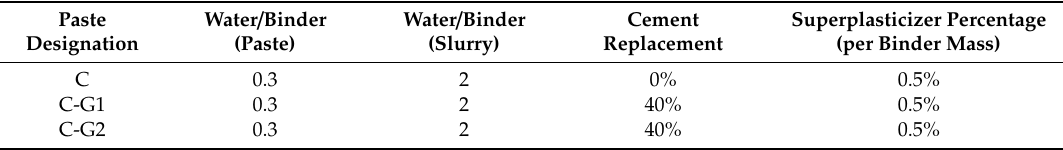
Table 3. Mix design of pastes and